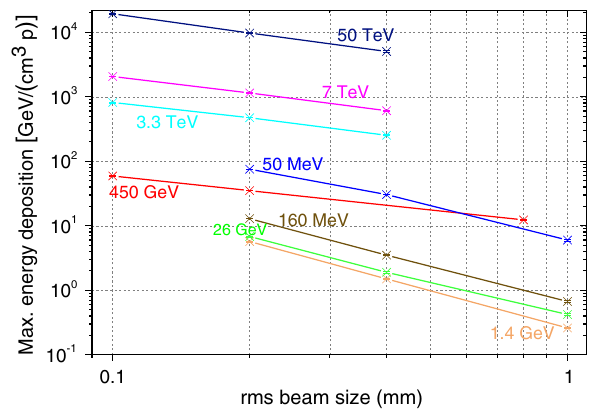
FIG. 8. Maximum energy deposition in copper as a function of the beam size for the energies from 50 MeV to 50 TeV.